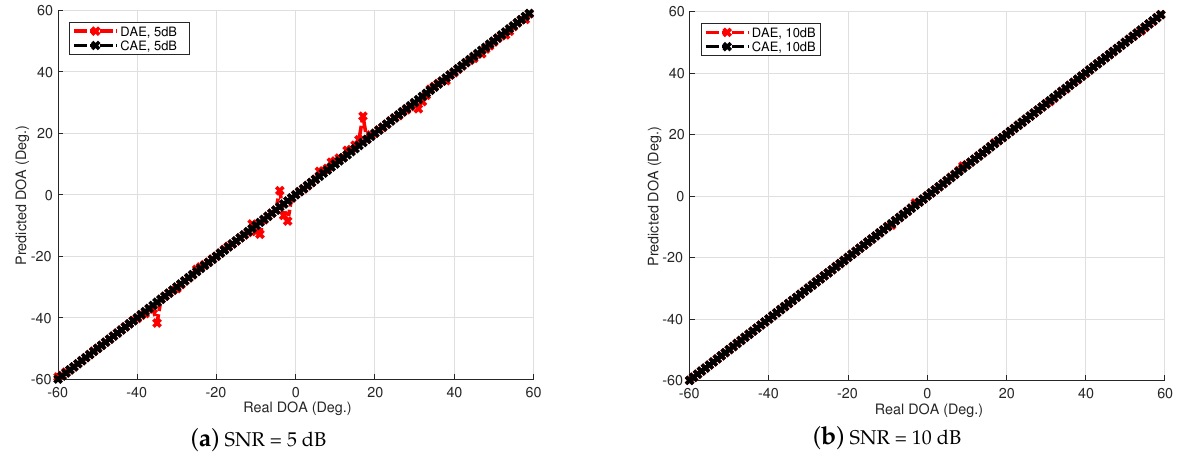
Figure 11. DOA prediction of DAE and CAE performed with combined array imperfections: ( a ) SNR = 5 dB, ( b ) SNR = 10